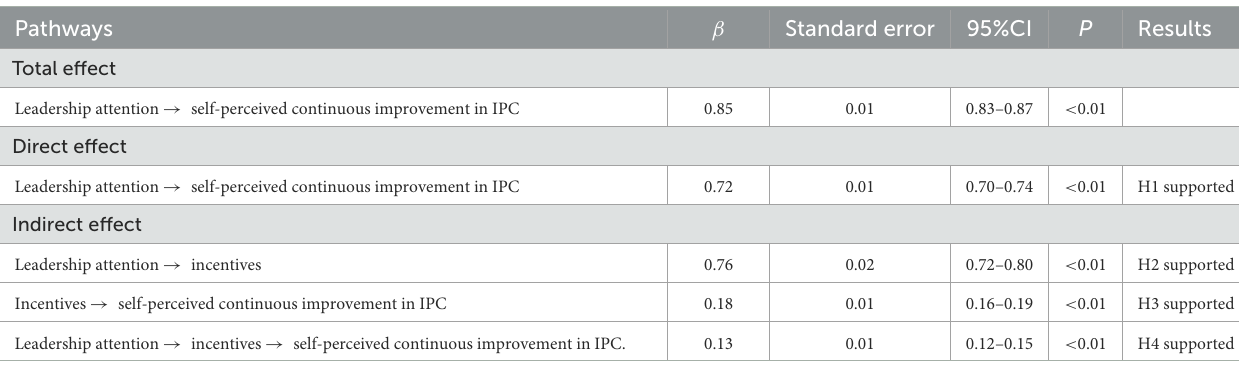
TABLE 3 Bootstrap test of the mediating effect of leadership attention on self-perceived continuous improvement in IPC.